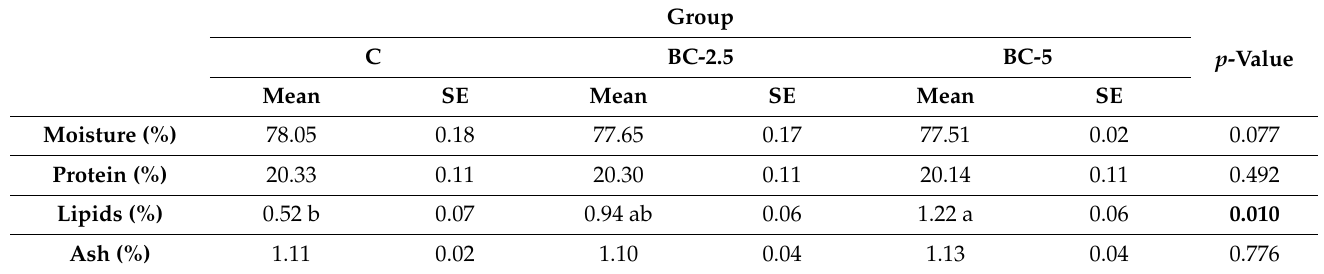
Table 2. Effect of colostrum inclusion in the diet of rabbits on the chemical composition (g/100 g) of the meat (mean ± standard error; SE). C = control diet; BC-2.5 = diet supplemented with 2.5% bovine colostrum; BC-5 = diet supplemented with 5% bovine colostrum. Group